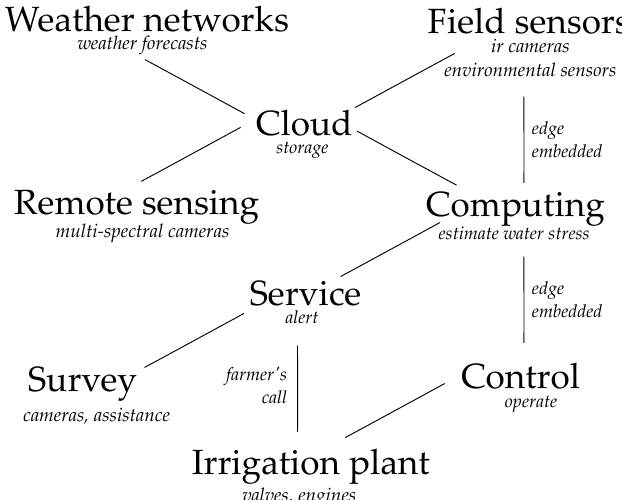
Figure 7. General framework of a field irrigation scheduling